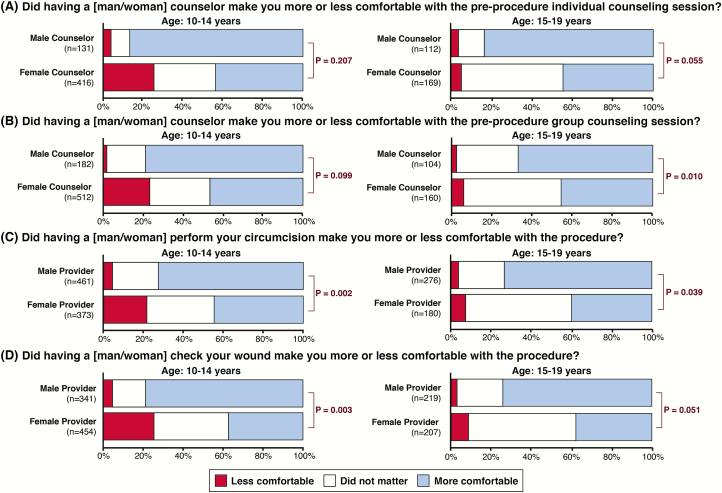

A–D, Gender preferences in the provision of voluntary medical male circumcision counseling and services among adolescents. Differences in the distribution of ordinal Likert responses between groups were assessed using the nonparametric Somers D test with Fisher Z transformation; the Somers D tests accounted for facility-level clustering using the delta-jackknife method and adjusted for country by stratification.